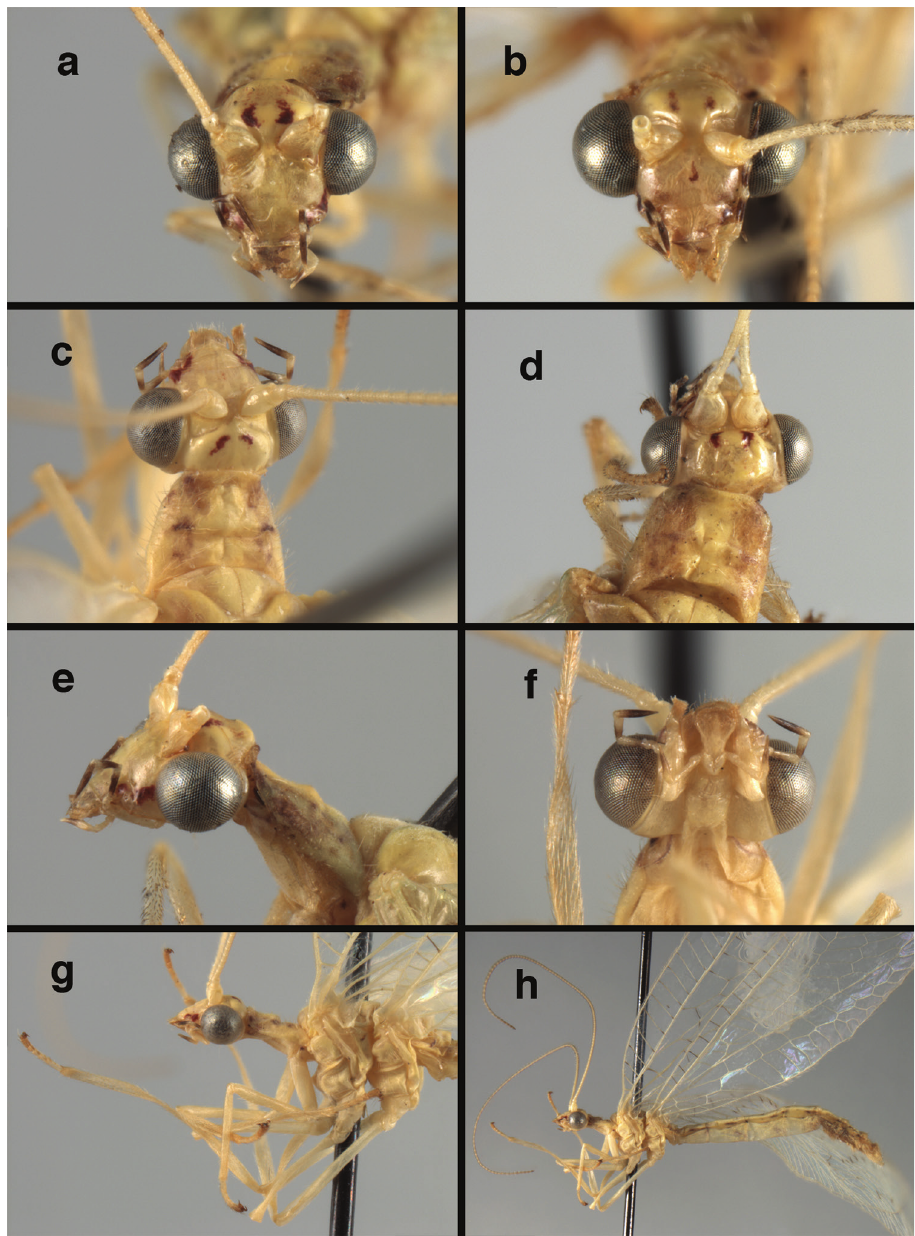
Figure 53. Ungla laufferi (Navás): External features, ( a, b ) head, frontal [Note variation in marks on vertex and frons.] ( c, d ) head, prothorax, dorsal ( e ) head, lateral ( f ) head, ventral ( g ) head, thorax, lateral ( h ) body, lateral ( a, e Peru, Lima, male, FSCA; b Ecuador, Huancavelica, male, CAS; c, f, g, h Peru, Cuzco, male, FSCA; d Peru, Lima, female,